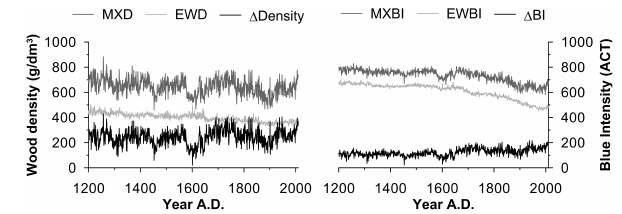
Figure 5. Left panel chronologies are mean earlywood density (EWD), maximum latewood 3 Fig. 5. Left-panel chronologies are mean EWD, MXD and density (MXD) and Δ Density. Right panel chronologies are earlywood blue absorption 4 1 density. Right-panel chronologies are EWBI, MXBI and 1 BI. intensity (EWBI), maximum latewood blue absorption intensity (MXBI) and Δ BI. The 5 The chronologies are raw data; no standardisation has been applied. chronologies are raw data; no standardisation has been applied. The blue intensity data is 6 The blue intensity data is produced using an adjusted colour target produced using an adjusted colour target IT8/7 (ACT) (see Supplementary Material, Fig. S1). 7 IT8/7 (ACT) (see Supplement Fig. S1). The variance is much larger The variance is much larger in MXD and Δ Density compared to MXBI and Δ BI. On the other 8 in MXD and 1 density compared to MXBI and 1 BI. However, the hand, the spread of series mean values is relatively larger for the blue intensity data (see 9 spread of series-mean values is relatively larger for the blue inten- Supplementary Material, Fig. S4). 10 sity data (see Supplement Fig.